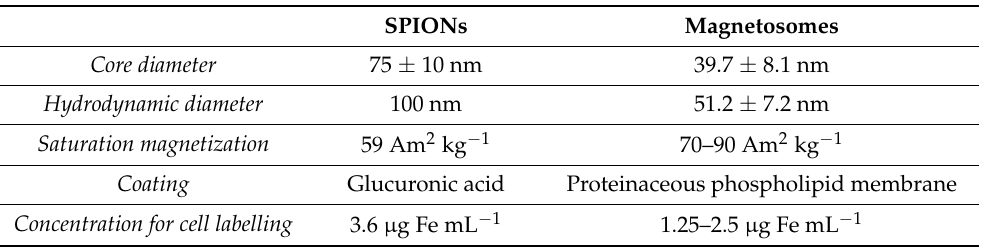
Figure 4. TEM analysis of hippocampal neurons incubated for 72 h with 1.25 µg mL −1 of magnetosomes ( A ) and with 3.6 µg Fe mL −1 of superparamagnetic iron oxide nanoparticles (SPIONs) ( B ). Representative micrograph of axon cross-sections. White and black stars highlight some particles in the axoplasm and at the membrane, respectively. Scale bar: 500 nm. Table 1. Comparison between superparamagnetic iron oxide nanoparticles (SPIONs) and bacterial magnetosomes.